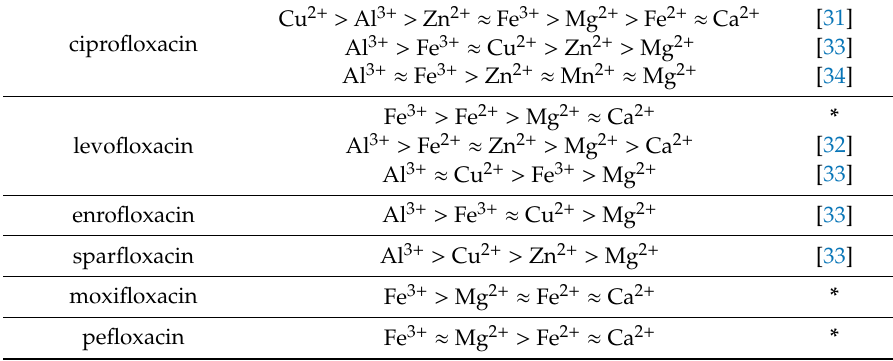
Table 2. FQ–cation apparent association constant